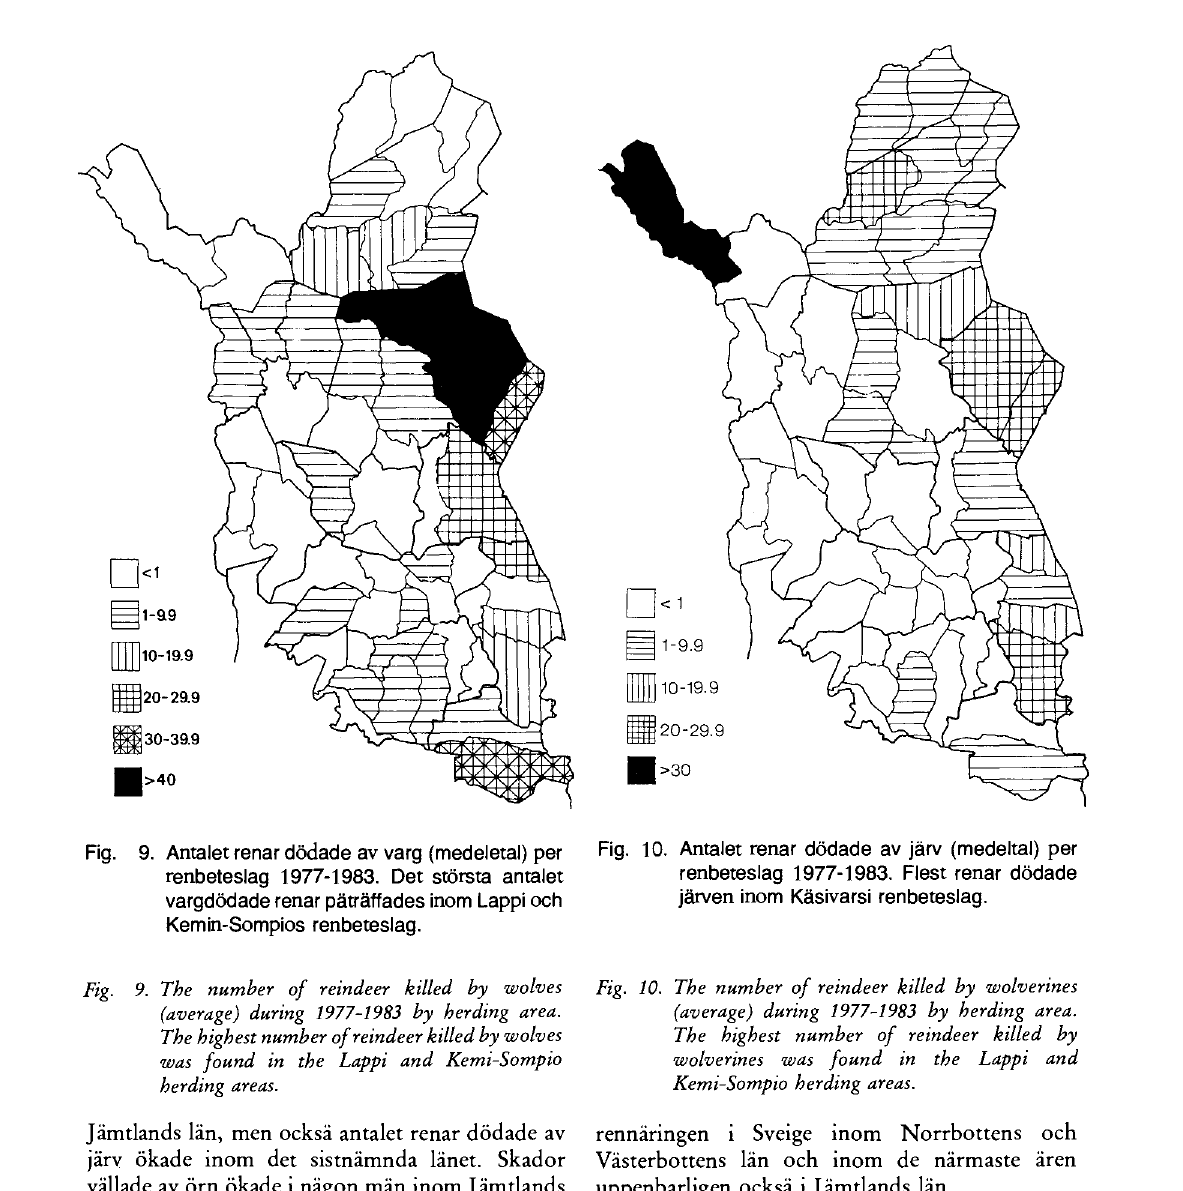
Fig. 9. The number of reindeer killed by wolves (average) during 1977-1983 by herding area. The highest number of reindeer killed by wolves was found in the Lappi and Kemi-Sompio herding areas.